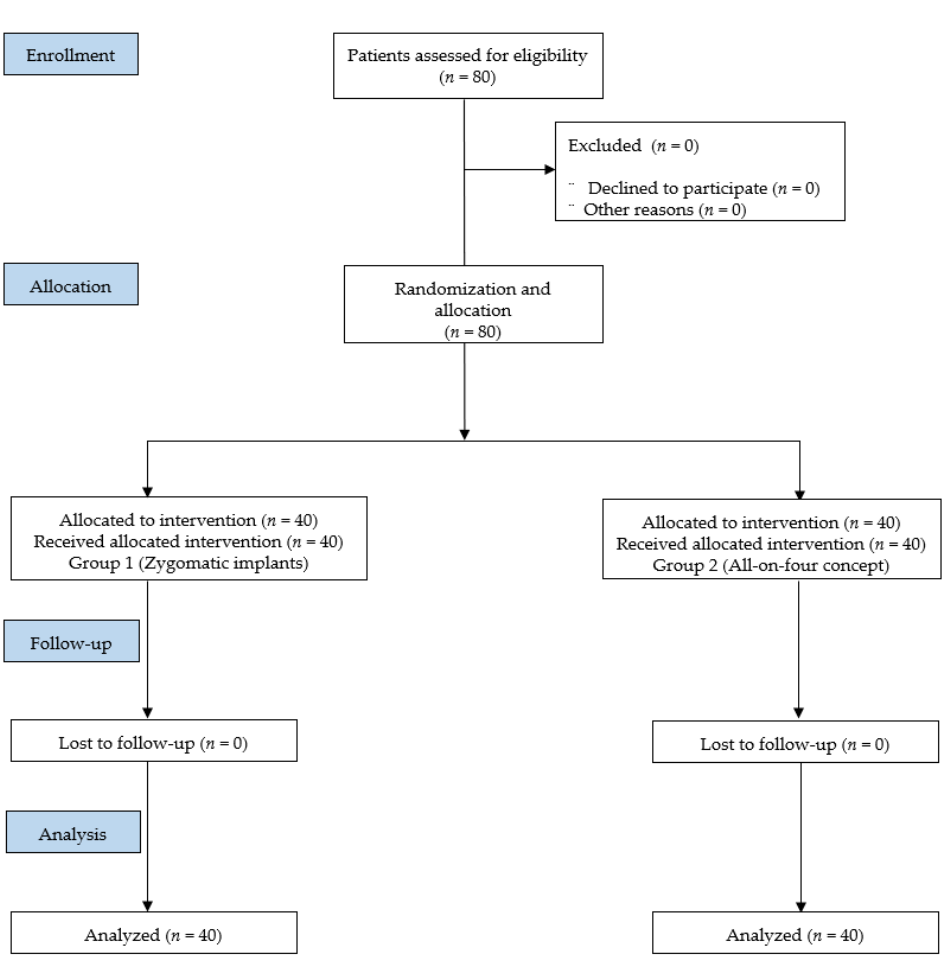
Figure 1. Flowchart of patient recruitment into this study according to the Consolidated Standards of Reporting Trials (CONSORT) statement.